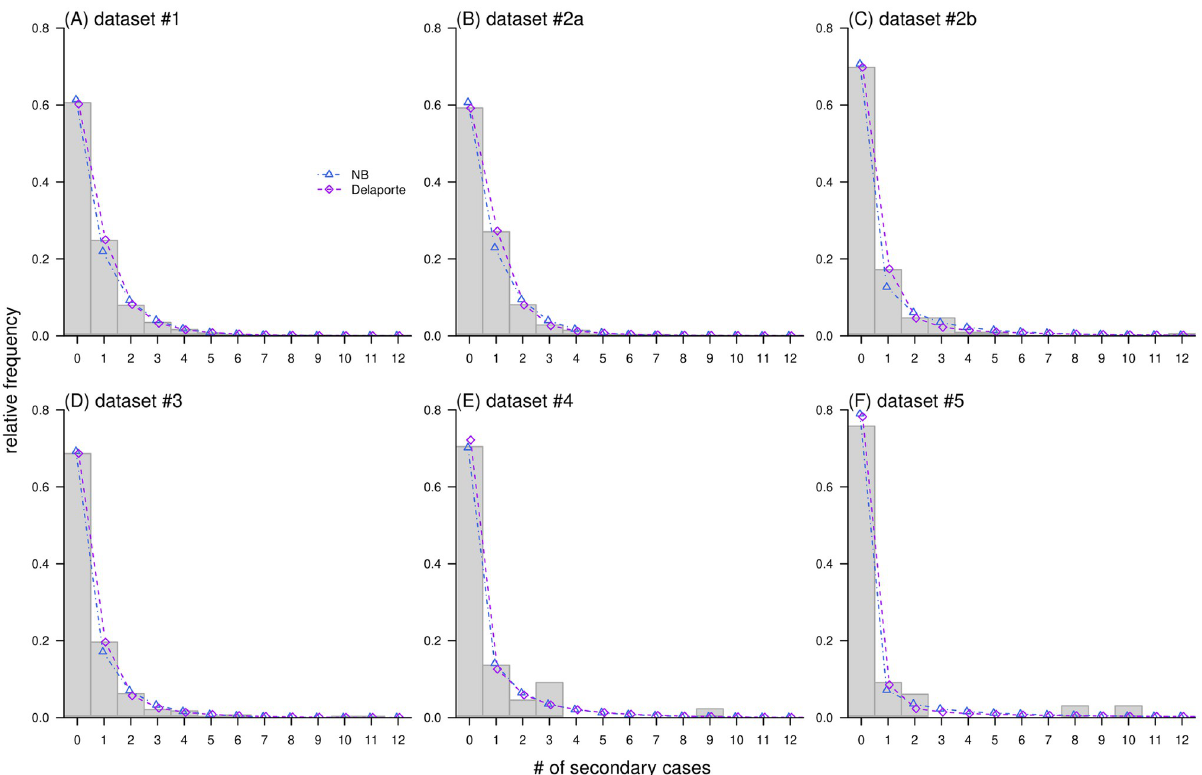
Fig 5. Fitting results of offspring distributions using the medians of posterior distributions for model parameters. In each panel, probability mass functions (PMF) of negative binomial (NB, in blue), and Delaporte (in purple) distributions are shown in dots and lines, and the observations of number of secondary cases per infector (in grey) are in histogram. Note : The PMFs of NB and Delaporte distributions were shifted horizontally in each panel with slight jitters at − 0.05 and +0.05, respectively to aid visualization and comparison.